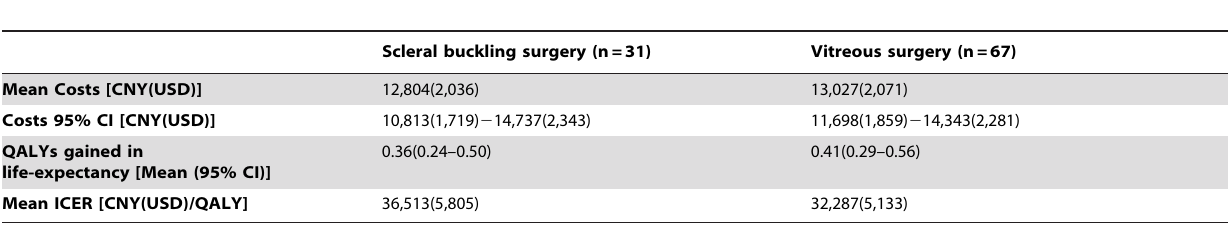
Table 5. Results of cost-utility analysis for the two surgery types in an elderly RRD population (bootstrap, n =1000).